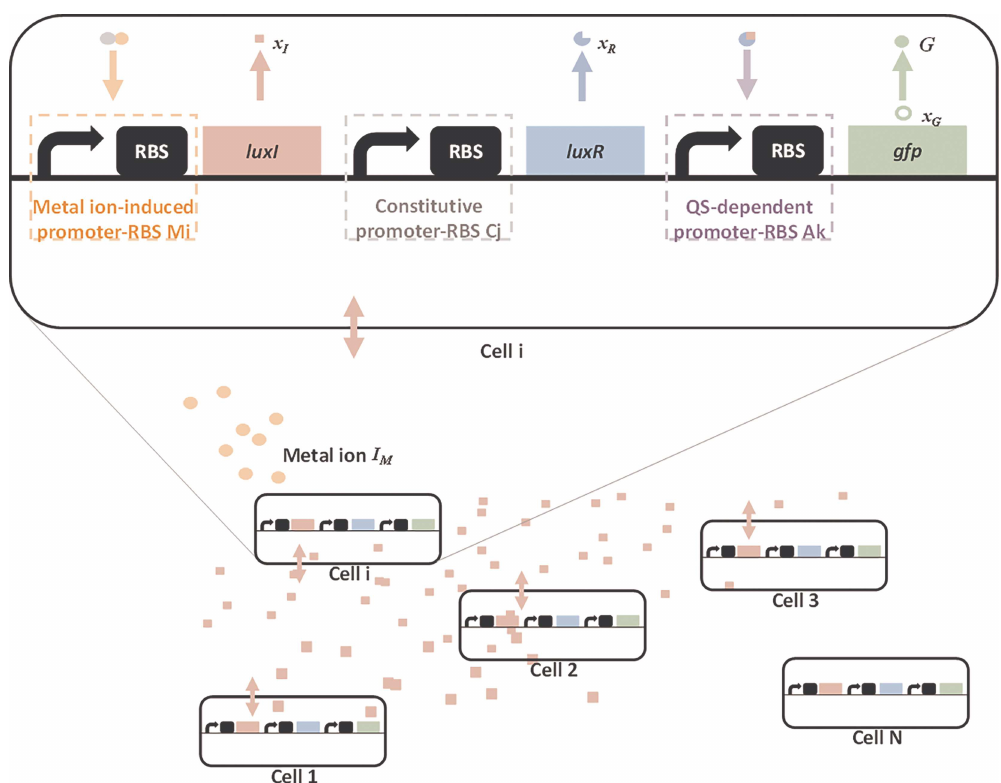
Fig 1. A metal ion biosensor. The metal ion biosensoris assembledby selectinga set of promoter-RBS componentsfrom the corresponding componentlibrariesin S1 File, namely, a metal ion-inducedpromoter-RBS component M i from the componentlibrary in Table A in S1 File, a constitutive promoter-RBS component C j from the componentlibrary in Table B in S1 File, and a QS-dependentpromoter-RBScomponent A k from the component library in Table C in S1